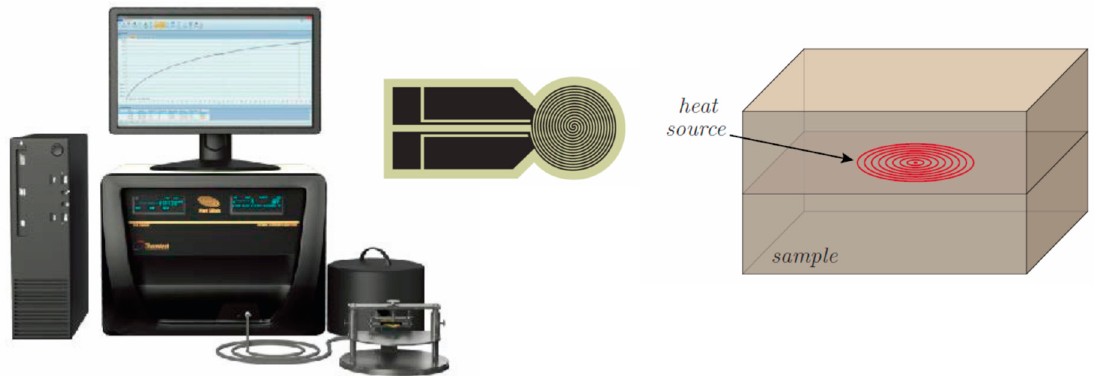
Figure 3. Schematic of the experimental setup for the thermal characterization.